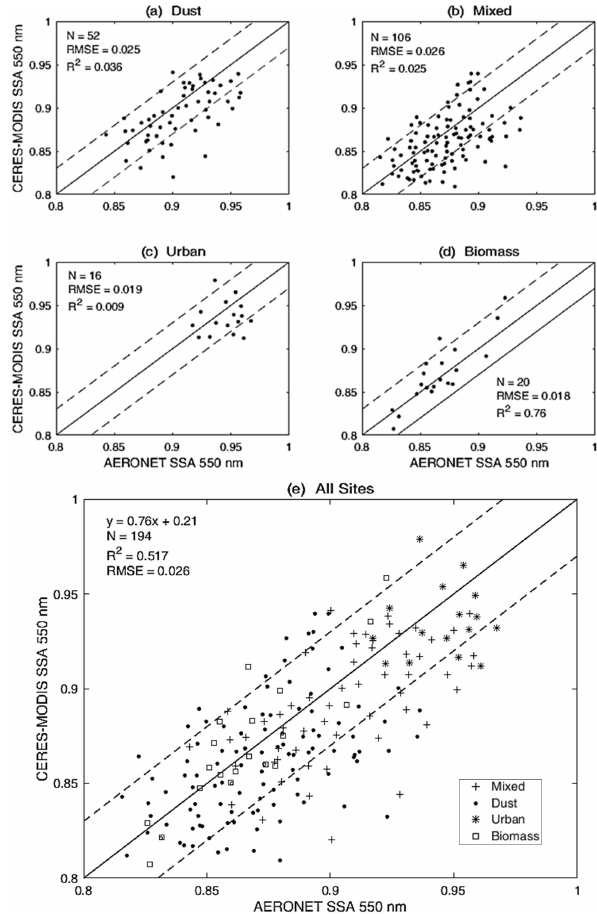
Figure 7. CERES-MODIS SSA (550nm) vs. AERONET SSA (550nm) for various AERONET sites classified based on the type of aerosols (Giles et al., 2012), for (a) dust, (b) mixed, (c) urban, (d) biomass burning, and (e) combined results.